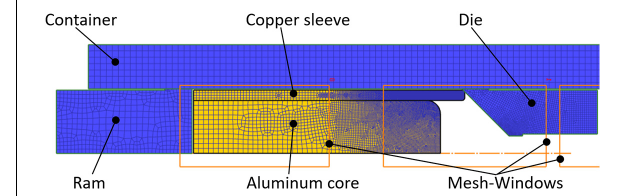
FIGURE 1 | FE-model for the extrusion of CCA rods.